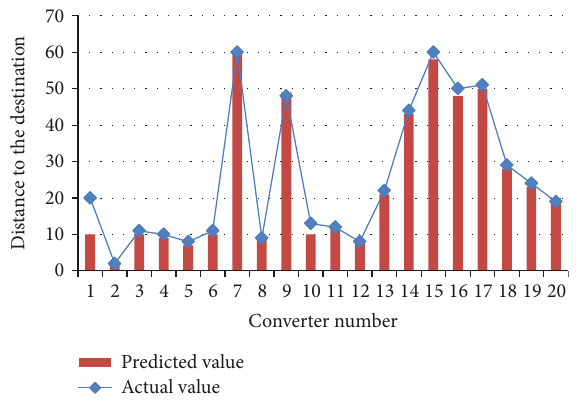
Figure 15: Distribution graph of the predicted value and the actual